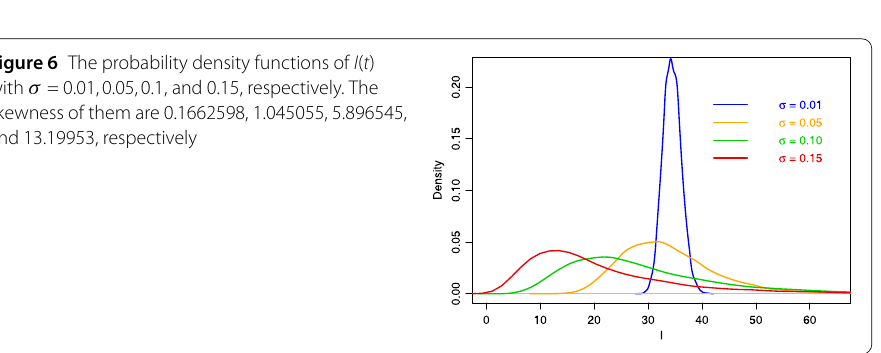
Figure 6 The probability density functions of I ( t ) with σ = 0.01,0.05,0.1, and 0.15, respectively. The skewness of them are 0.1662598, 1.045055, 5.896545, and 13.19953,